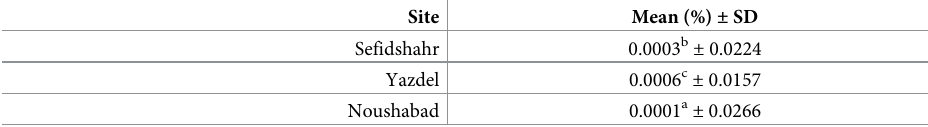
Table 4. Comparison of the means related yield of R . damascena EO at the studied crop sites.